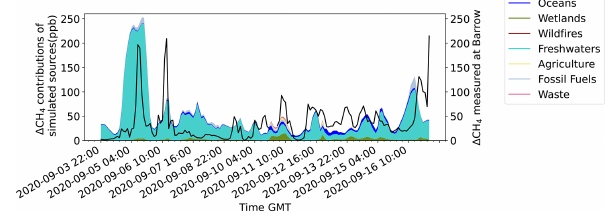
Figure 12. Comparison of enhancement of measured CH 4 (black line) and simulated CH 4 (colored stacked plot) at Barrow station during the whole